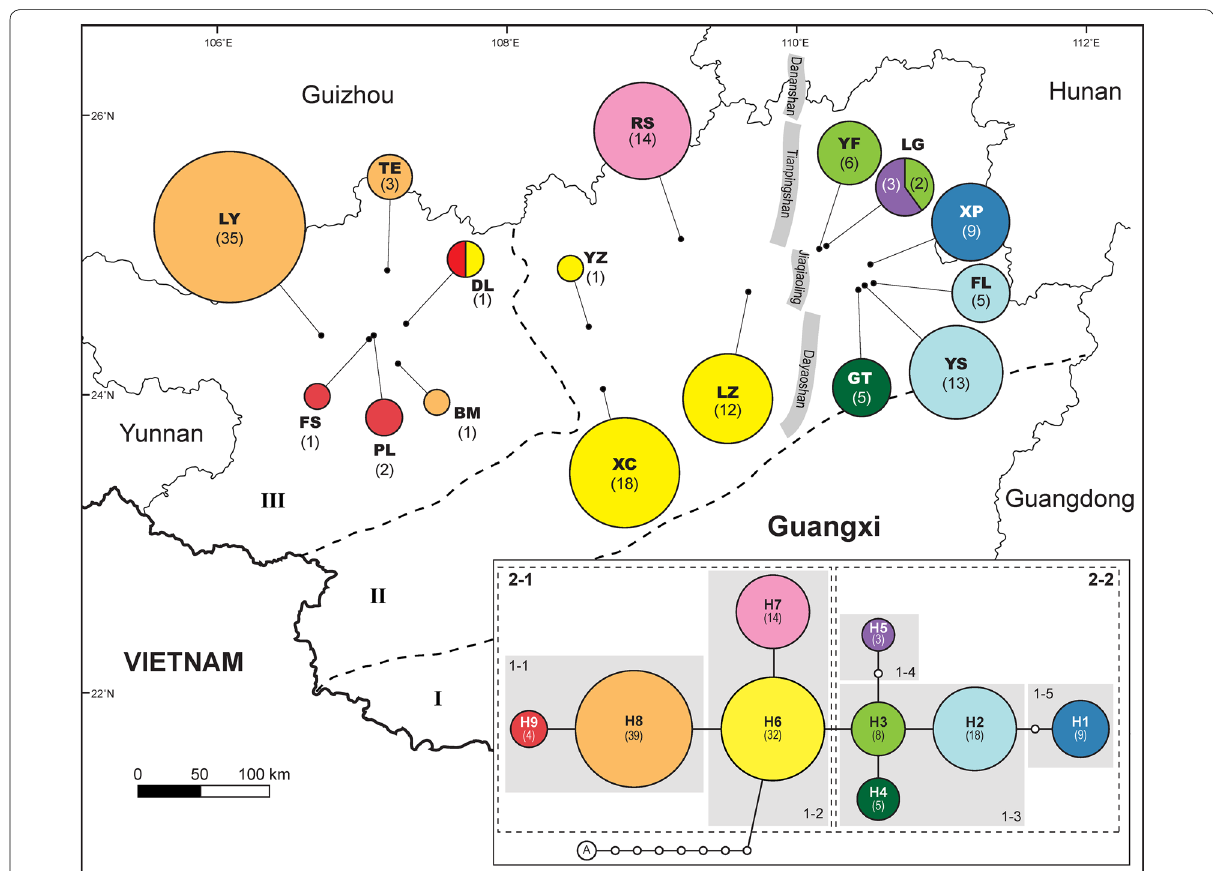
Fig. 4 Distribution of trnC ‑ ycf6 haplotypes, haplotype network, and nested clade design in B. luzhaiensis . Statistical parsimony network was generated by TCS 1.21 rooted by B. asteropyrifolia (A). The size of circles is proportional to haplotype frequency, which is also indicated in the circles. Dash lines demarcate three types (I, II, and III in Fig. 2) of karst landforms in Guangxi based of Liu et al. (2001)’s